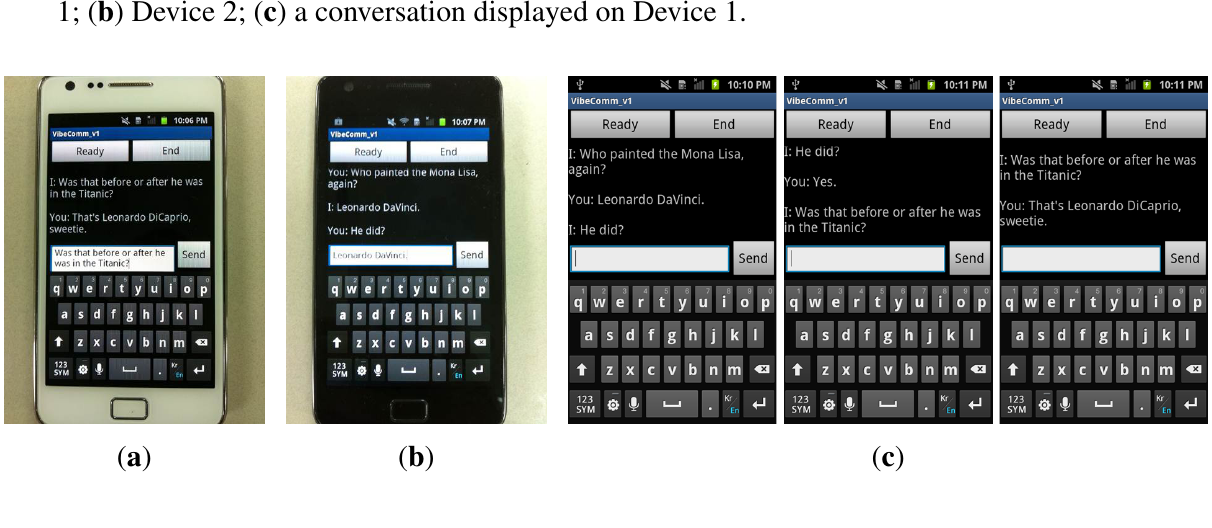
Figure 16. A demonstration of the two-way communication for exchanging text messages. I denotes a message sent from the device, and You denotes a received message. ( a ) Device